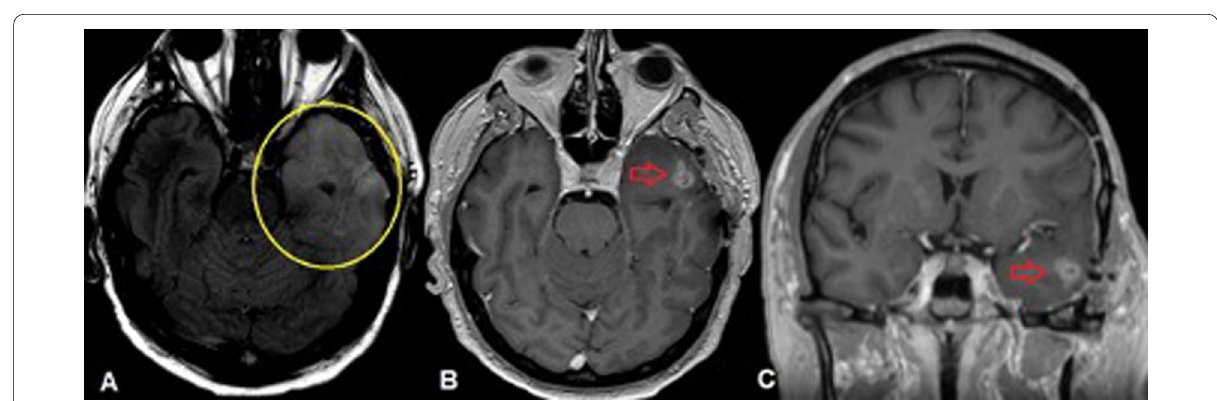
Fig. 2 MRI cerebral axial cuts ( A and B ) and coronal ( C ) displaying increased FLAIR component (yellow circle) and contrast uprising lesion (red